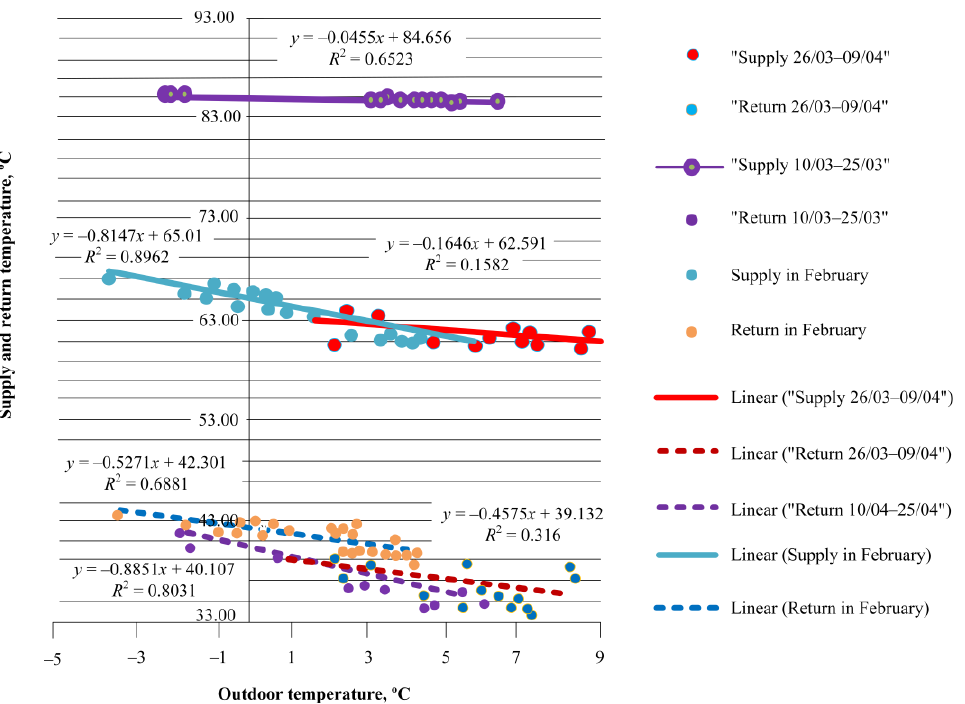
Fig. 4. Supply and return flow temperatures during the pre-experiment and